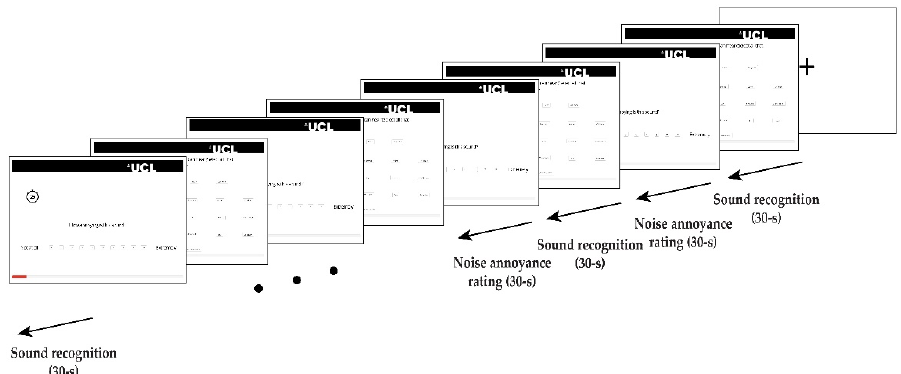
Figure 3. The online paradigm: A standard block design was used which auditory stimuli were presented for 15 s, followed by 15 s for sound sources labelling; after the sound source recognition, the same stimulus was presented again for 15 s and followed by 15 s for the annoyance rating task.